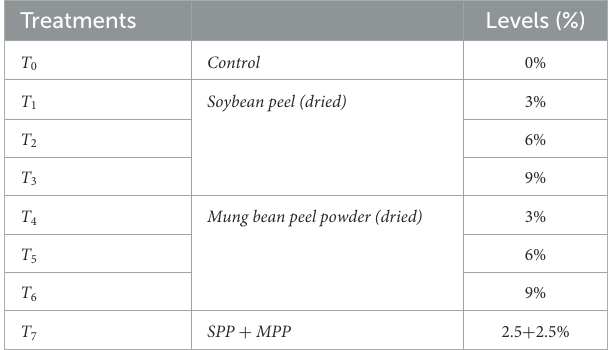
TABLE 2 Treatment